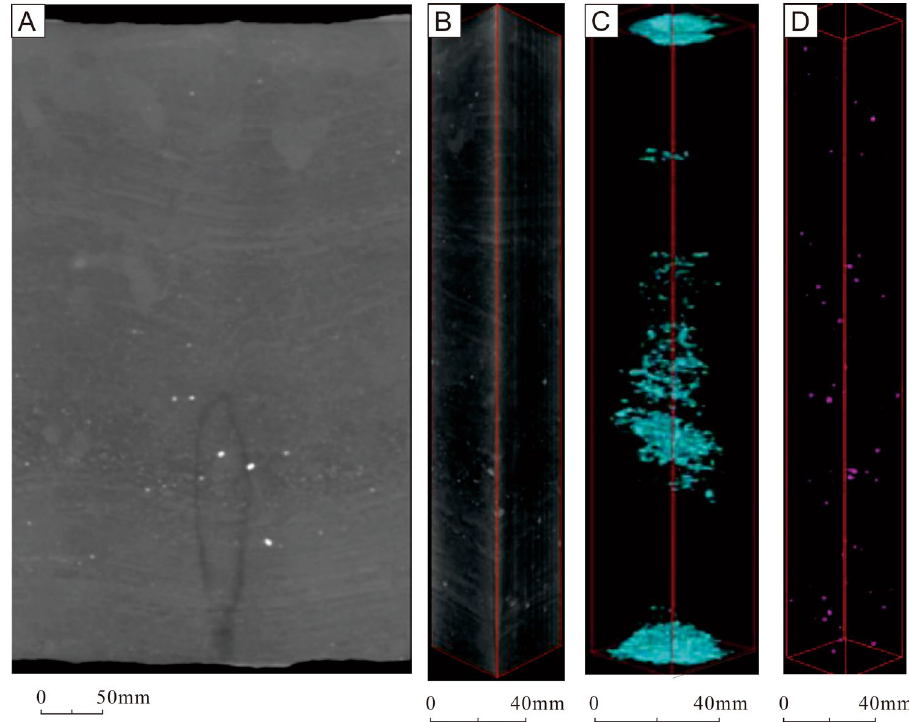
Figure 5. Interior structure reconstructed by ICT analysis. ( A ) ICT Circumferential View; ( B ) Images reconstructed by computed tomography; ( C ) 3-D Volume-rendering of open fractures (colored cyan); ( D ) 3-D Volume-rendering of calcite-filled